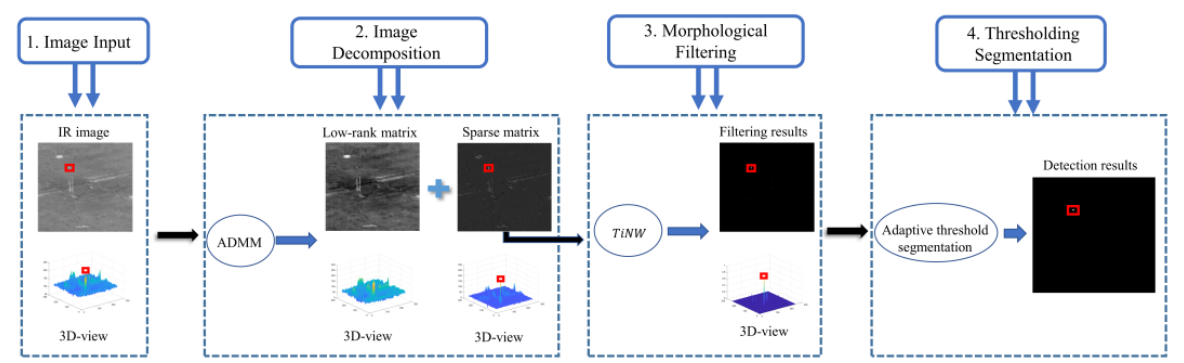
Figure 3. The workflow of the proposed method. red squares represents small target.